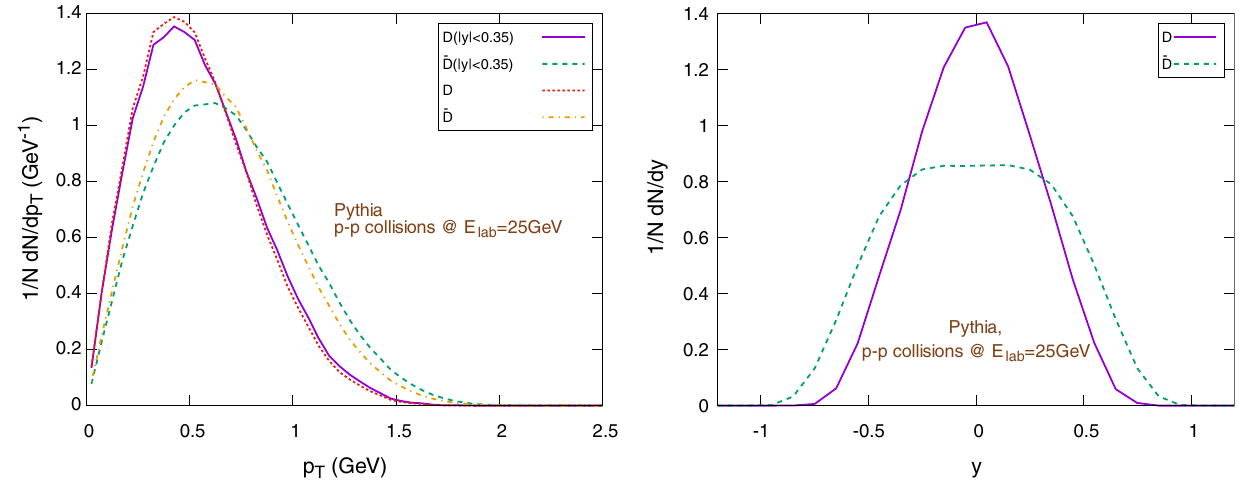
Fig. 9 Spectra of D / ¯ D-mesons in p–p collisions sampled with Pythia. The left figure shows the (normalized) 1 / N d N / d p T distribution (in the rapidity range | y | < 0 . 35), the right figure shows the (normalized) 1 / N d N / d y